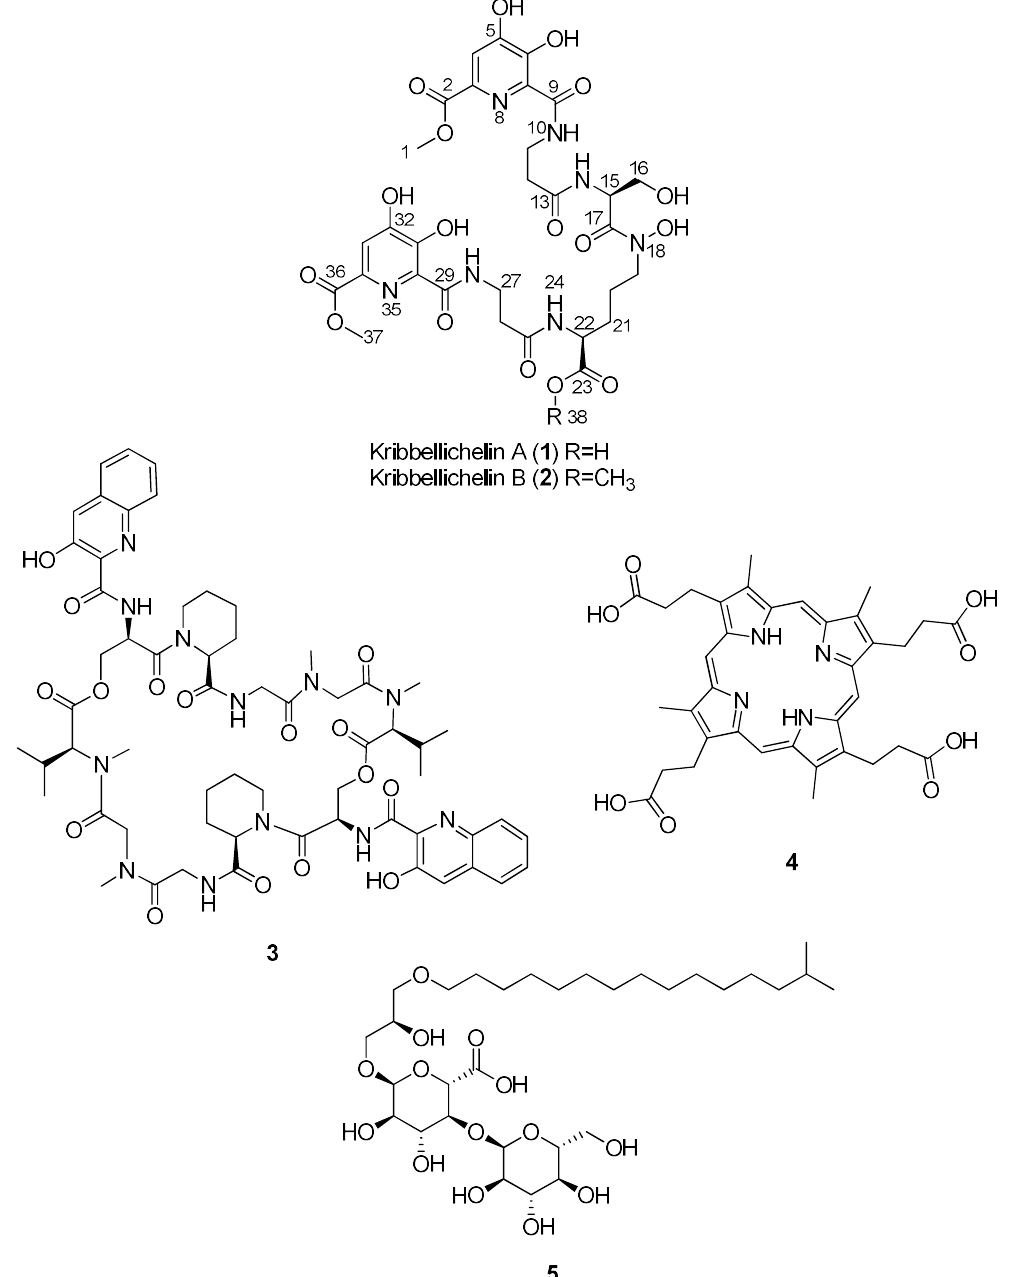
Figure 2. Structures of kribbellichelins A ( 1 ) and B ( 2 ), sandramycin ( 3 ), coproporphyrin III ( 4 ), and kribelloside C ( 5 ).